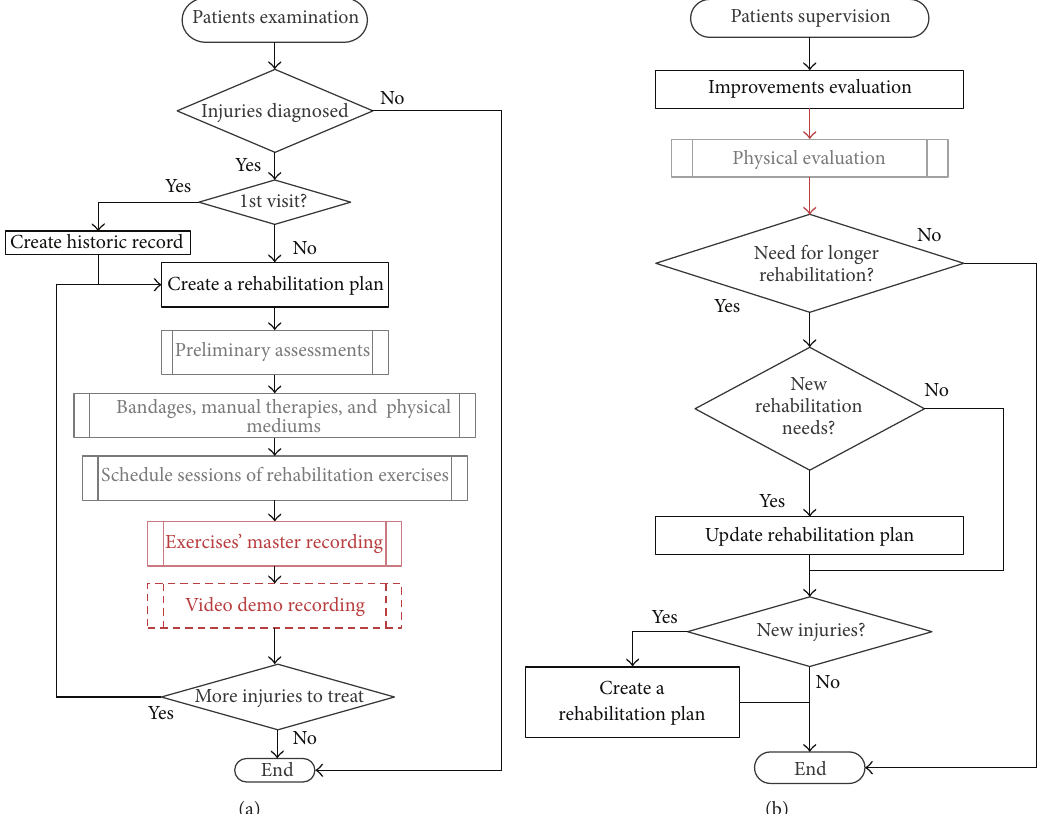
Figure 3: Flow diagram of rehabilitation attention processes using eFisioTrack. On the left, patient’s 1st examination and on the right, patient’s improvements